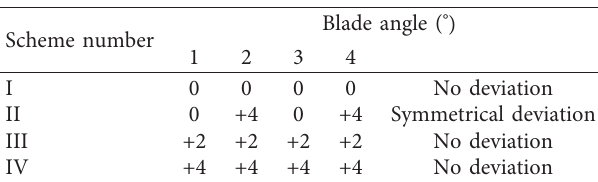
Table 1: Design scheme